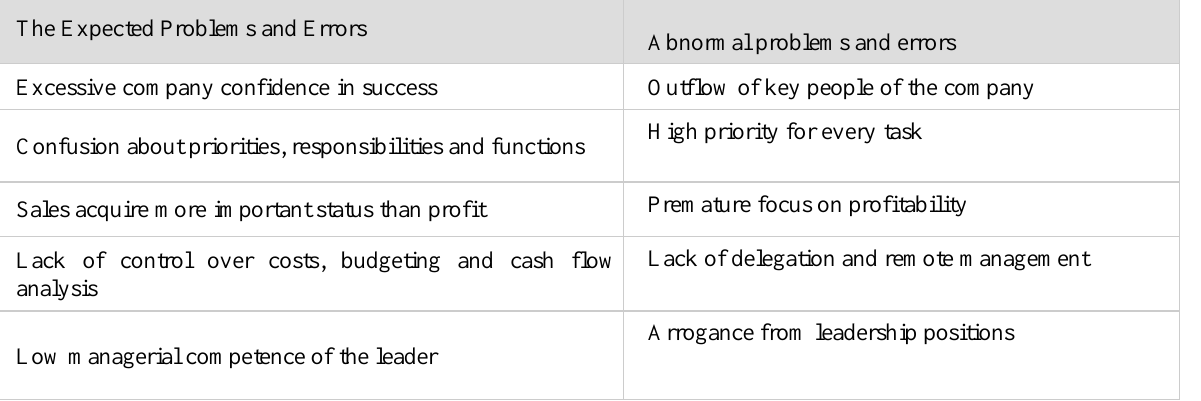
Abnormal problems and